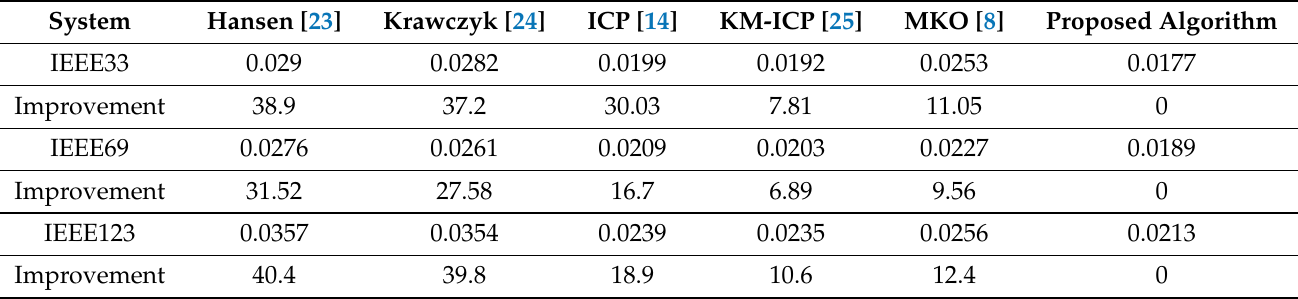
Table 1. The average width of voltage magnitudes for the three systems.